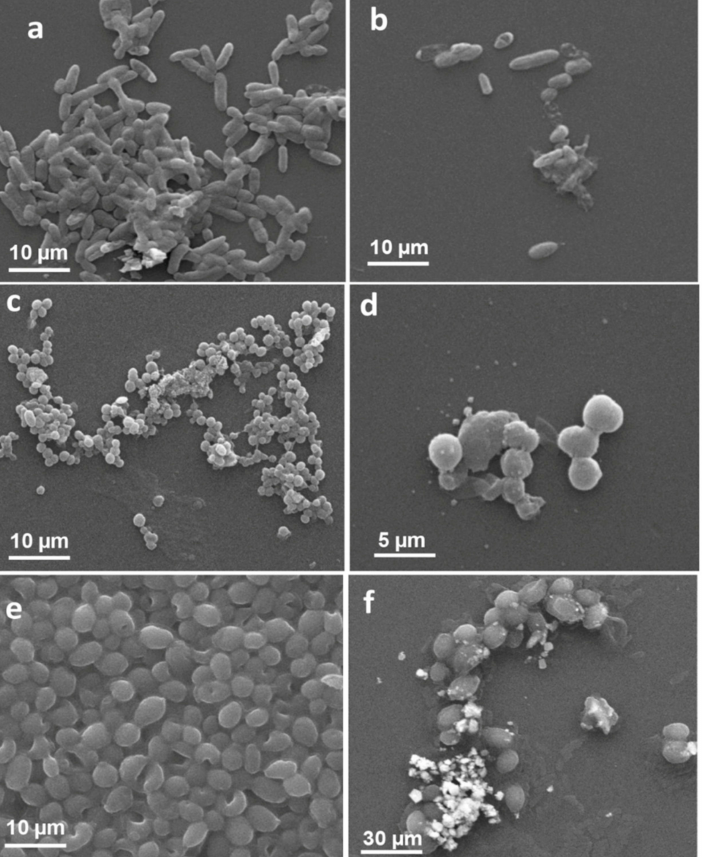
Figure 10. Microscopic analysis of biofilm inhibition. SEM micrographs of biofilm formed by MDR- PA, MRSA and C. albicans strains grown in absence ( a , c , e ) and presence ( b , d , f ) of 100 µ g/mL of LIV-AgNPs.